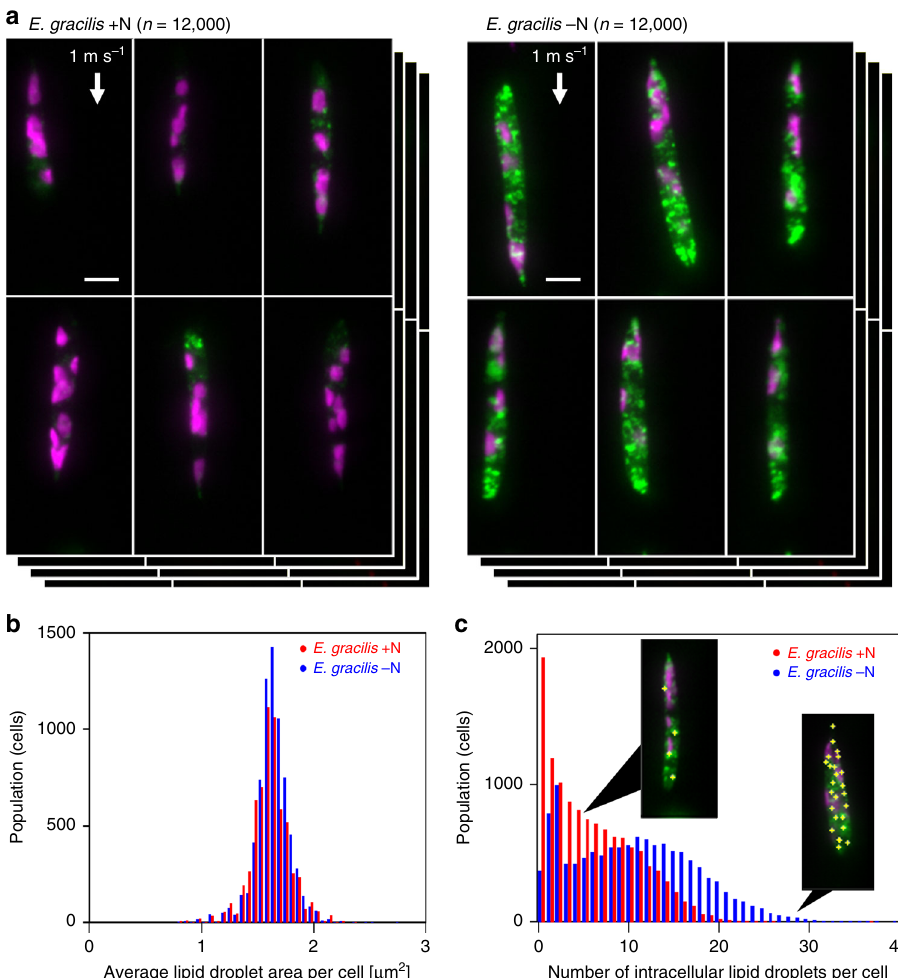
Fig. 5 High-throughput, high-content screening of E. gracilis cells. a Fluorescence images of nitrogen-suf fi cient ( + N) and nitrogen-de fi cient ( − N) E. gracilis cells ( n = 12,000 for each group) obtained by VIFFI fl ow cytometry. The lipids (shown in green) were stained by BODIPY505/515 while chlorophyll (shown in magenta) was auto fl uorescent. See Supplementary Figs. 16 and 17 for more images. b Histograms of E. gracilis cells in the average droplet area per cell ( n = 7499 for each group). The source data is available in our Source Data fi le. c Histograms of E. gracilis cells in the number of intracellular lipid droplets per cell ( n = 11,999 for each group). Yellow plus signs in the insets indicate the locations of lipid droplets within the cell body. It is important to note that while the average droplet area does not change under two culture conditions, the number of lipid droplets varies signi fi cantly. The near-origin peak of the E. gracilis – N histogram is due to isolated lipid droplets, presumably caused by the fracture of cells in the sample preparation process (see Supplementary Fig. 21). The source data is available in our Source Data fi le. Scale bars: 10 µ